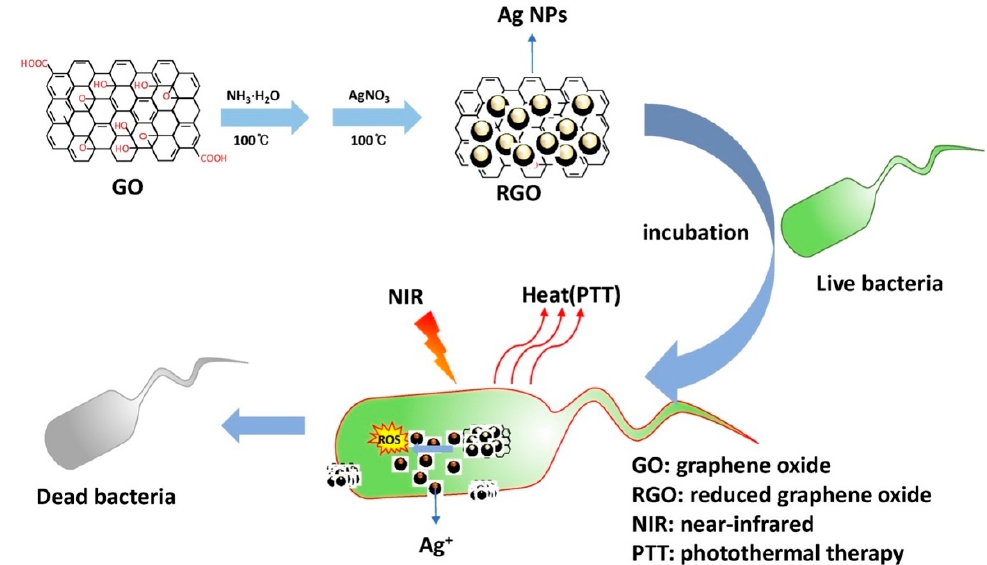
Figure 9. Schematic representation of the photothermal killing of microbes by silver nanoparticles (Ag NPs) embedded in reduced graphene oxide (RGO/Ag). Reproduced from [73], with permission from Elsevier, 2020.